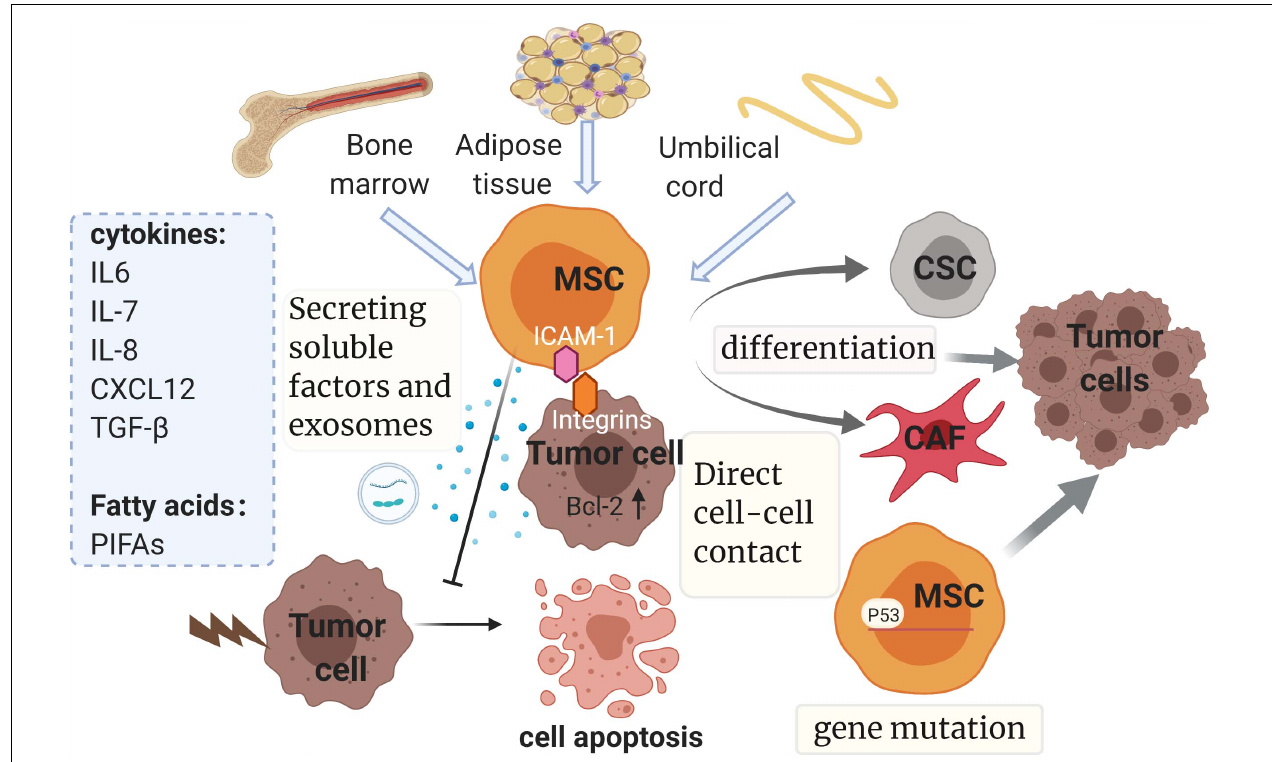
FIGURE 4 | Mesenchymal stem cells and drug resistance. Mainly isolated from bone marrow, adipose tissue and umbilical cord, MSCs promote drug resistance in multiple ways, such as secreting soluble factors and exosomes, genetic mutations, direct cell-cell contact and differentiating into CAF or CSC. The diverse soluble factors and exosomes derived from MSCs could induce chemoresistance dependent on multiple pathways and downstream mechanisms, some of which relate to the inhibition of tumor cell apoptosis by regulating the expression of apoptosis-related proteins. It is noteworthy that chemoresistance properties of MSCs can be conferred via direct cell–cell contact with tumor cells as well. This interaction can enhance the expression of Bcl-2. Also, gene mutations such as p53 deficiency in MSCs could contribute to drug resistance by mediating antitumor immunity. Finally, MSCs have the potential to evolve into CAFs and CSCs, which have been reported to be involved in the development of resistance. MSC, mesenchymal stem cell; CSC, cancer stem cell; CAF, cancer-associated fibroblast; SDF-1: stromal cell-derived factor-1; TGF- β , transforming growth factor- β ; PIFAs, platinum-induced fatty acids. ICAM-1, intercellular adhesion molecule-1. The figure was created with